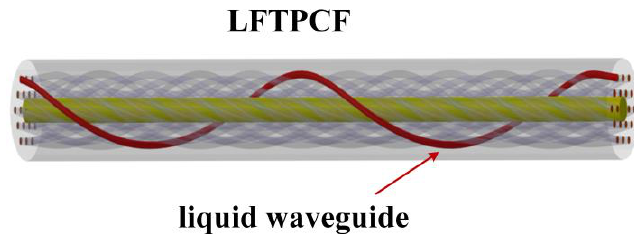
Figure 1. Schematic diagram of the LFTPCFs. The red path represented the liquid-filled air hole. When α 0 was set to be 3.142, 3.305, 3.489, 3.694, 3.925 rad / mm, and n l = 1.484 the dispersion